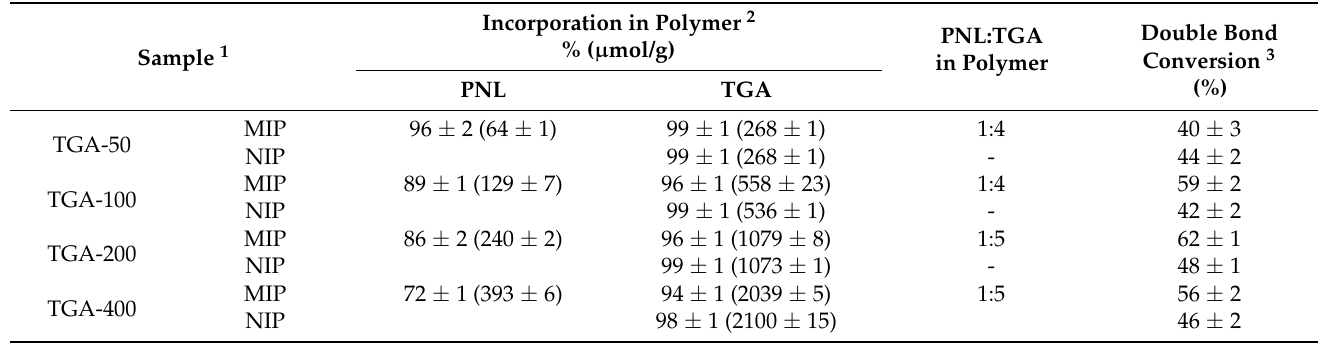
Table 1. Polymerisation and PNL-imprinting results with TGA MIPs and